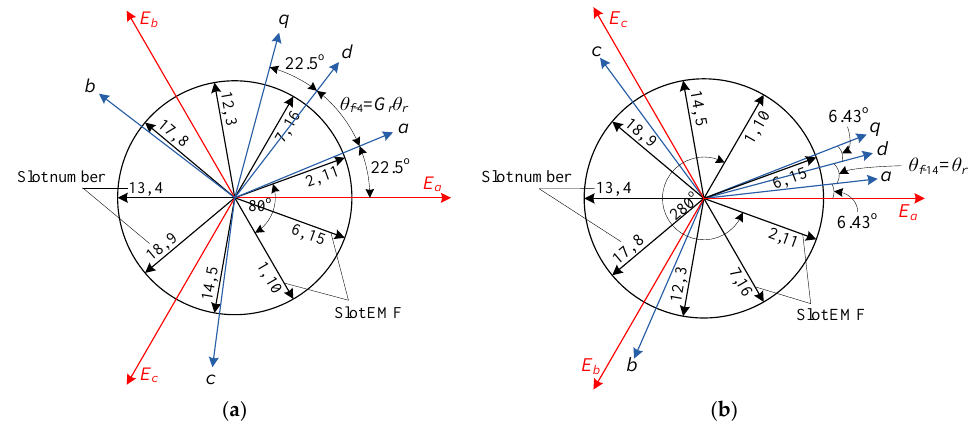
Figure 4. Slot electromotive force (EMF) star diagram and d-q axes definition of the proposed 18-slot/8-pole FMPM machine. ( a ) Based on 4 pole-pair field; and ( b ) based on 14 pole-pair field.